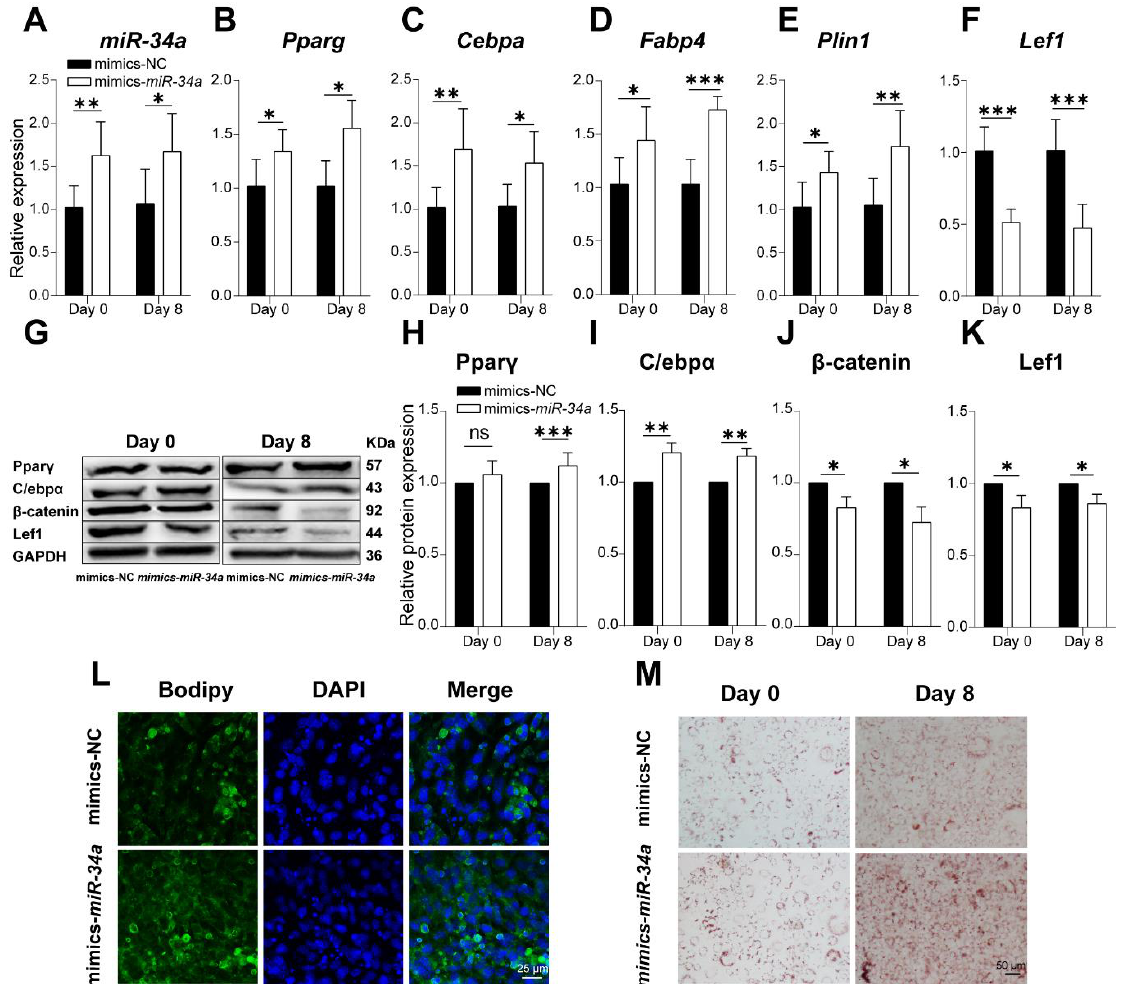
Figure 6. miR-34a overexpression promoted adipogenesis. ( A ) qPCR confirmed that 3T3-L1 cells stably overexpressed miR-34a after mimics treatments ( n = 6). The expression of Pparg ( B ), Cebpa ( C ), Fabp4 ( D ), Plin1 ( E ), and Lef1 ( F ) on day 0 and day 8 during 3T3-L1-derived preadipocyte differentiation after miR-34a mimics ( n = 6 ). The protein expression level of Pparγ ( G ), C/ebpα ( H ), β -catenin ( I ), and Lef1 ( J ) in NC and miR-34a mimics groups along with differentiation via Western blot ( n = 3) ( K ). Lipid droplet accumulation in 3T3-L1 cells on day 0 and 8 of differentiation detected using BODIPY staining ( L ) and Oil Red O staining ( M ) in NC and miR-34a mimics groups. * p < 0.05, ** p < 0.01, *** p < 0.001 versus NC.